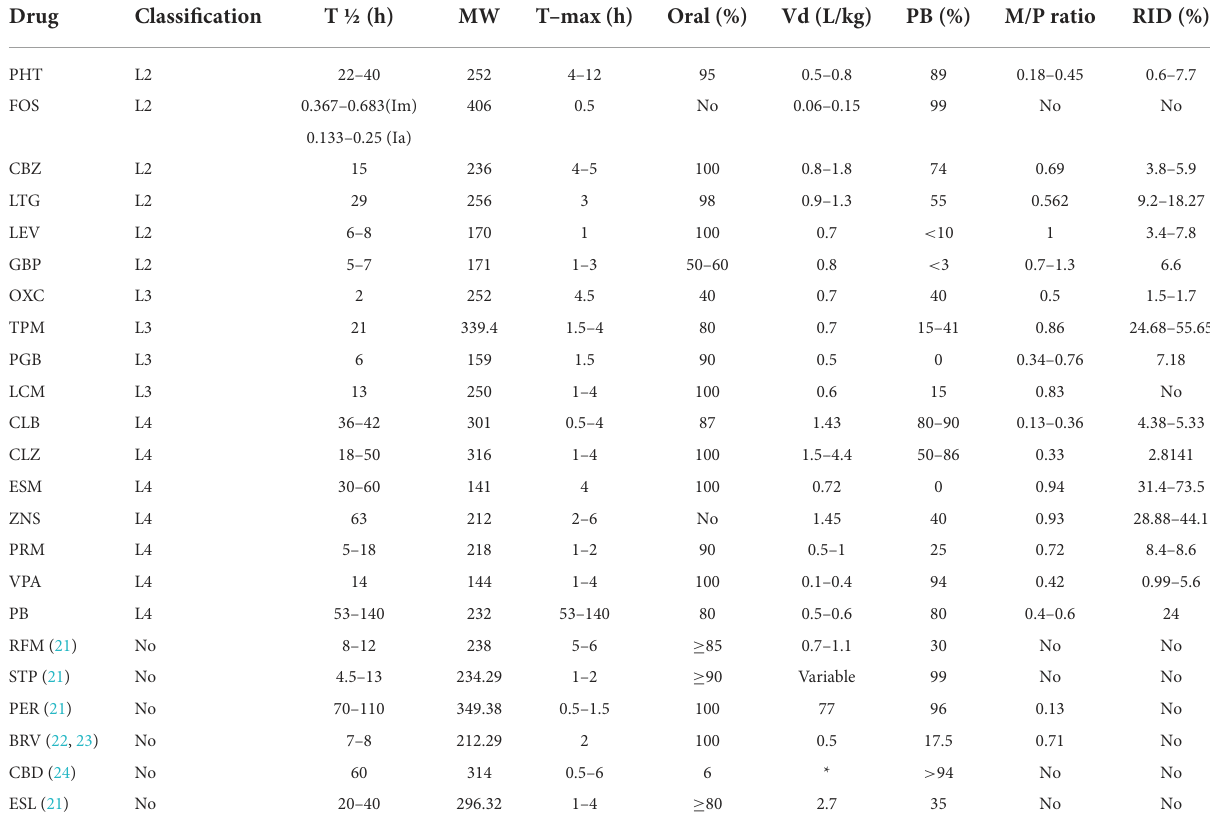
TABLE 1 Pharmacodynamics and M/P ratio, RID of some